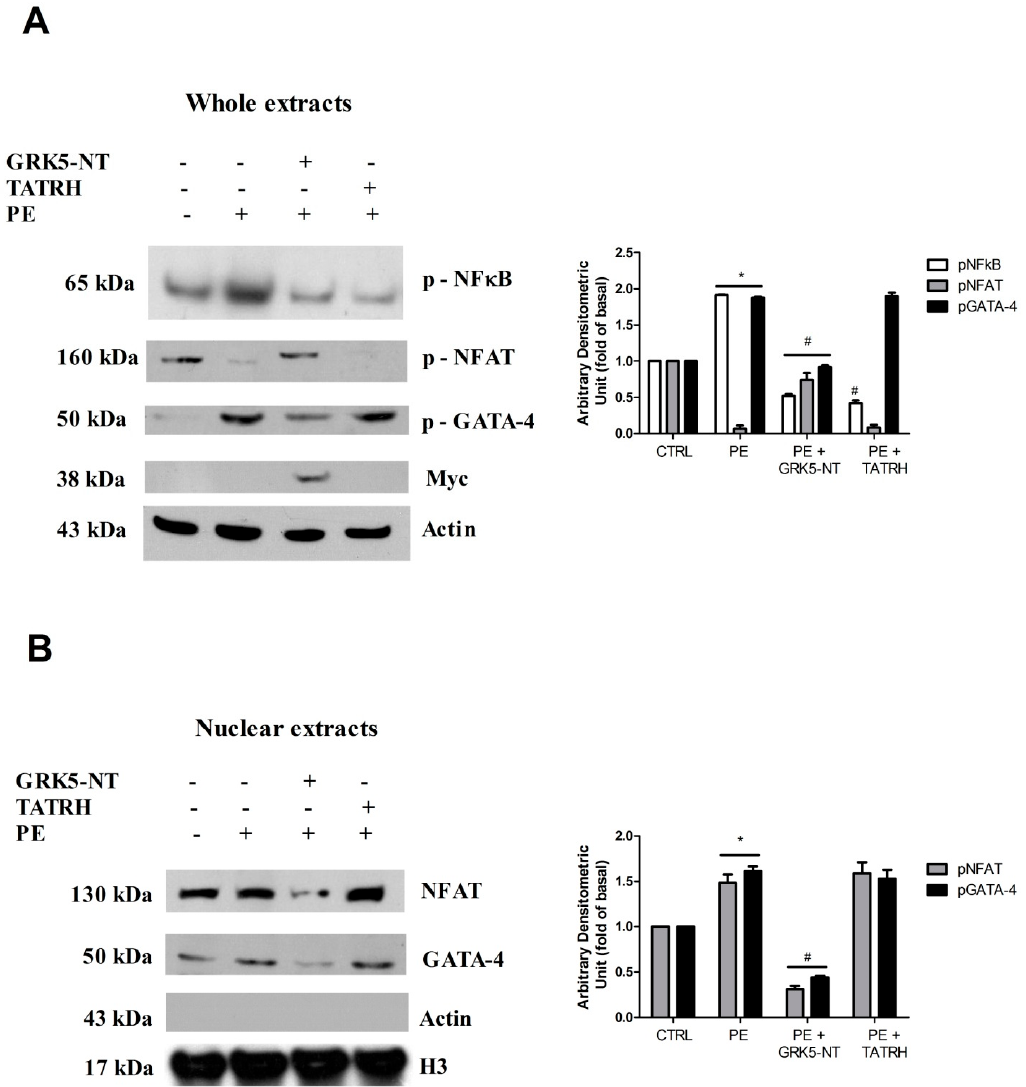
Figure 1. The amino-terminal domain of the G Protein Coupled Receptor Kinase 5 (GRK5-NT) regulates the activation of calcium-calmodulin dependent transcription factors in vitro. ( A ) In cultured cardiomyoblasts H9C2, hypertrophy was induced by chronic stimulation with Phenylephrine (PE) and the activation of NF κ B, nuclear factor of activated T cells (NFAT), and GATA-4 in response to PE was evaluated by western blot. PE triggered the phosphorylation of GATA-4, NF κ B and the dephosphorylation of NFAT. The overexpression of GRK5-NT reduces such phenomenon while TAT-RH, which has only the RH domain of GRK5, did not modify PE-induced GATA-4 and NFAT activation albeit being effective on NF κ B activation. Images are representative of three independent experiments. Densitometric analysis is shown in bar graph as mean ± SD; * p < 0.05 vs. Control and # p < 0.05 vs. PE; ( B ) nuclear accumulation of NFAT and GATA-4 was evaluated by western blot in nuclear extracts from H9C2 cells. GRK5-NT reduced the PE-dependent nuclear translocation of these factors while TATRH is not able to exert the same effect. Actin was used as control of nuclear extracts purity. Images are representative of three independent experiments. Densitometric analysis is shown in bar graph as mean ± SD; * p < 0.05 vs. Control and # p < 0.05 vs. PE.